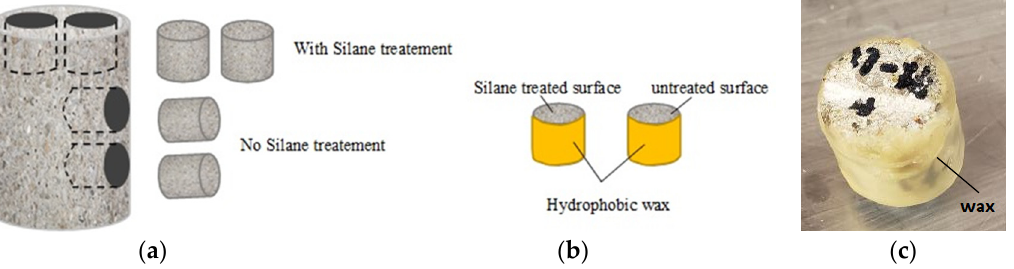
Figure 3. ( a ) Extraction of 25 mm diameter cores from each cylinder; ( b ) application of wax; ( c ) a real sample after applying a hydrophobic wax around the